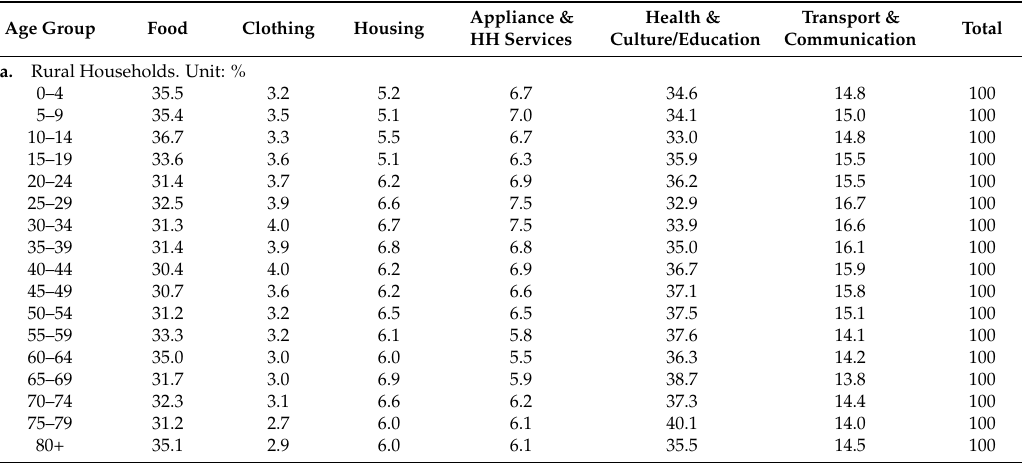
Table 2. Consumption Structure by Age